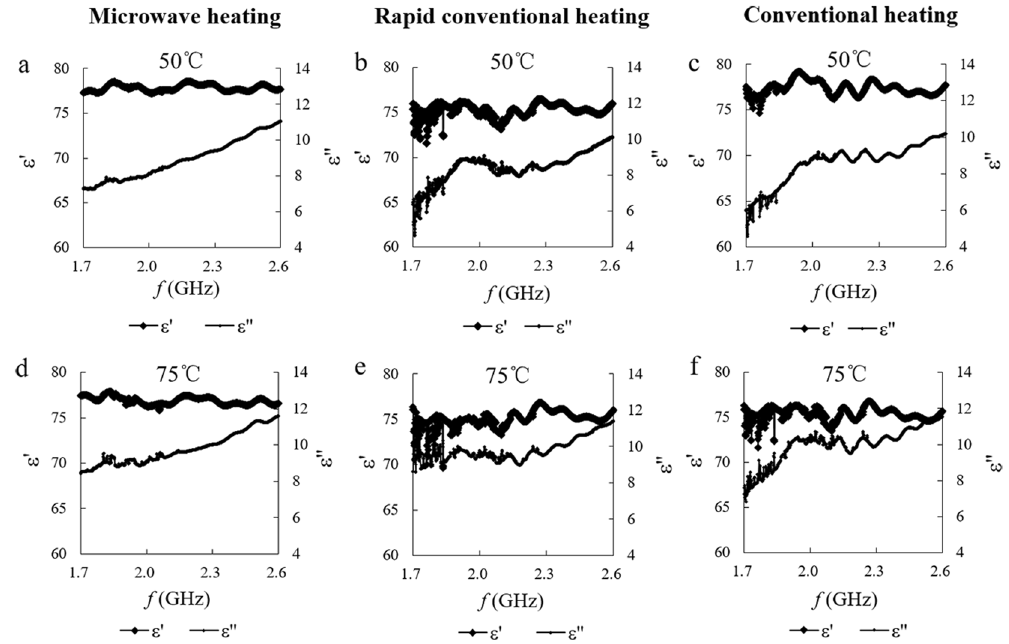
Figure 3. Frequency-scanning curves of dielectric properties of starch using different heating protocols under characteristic